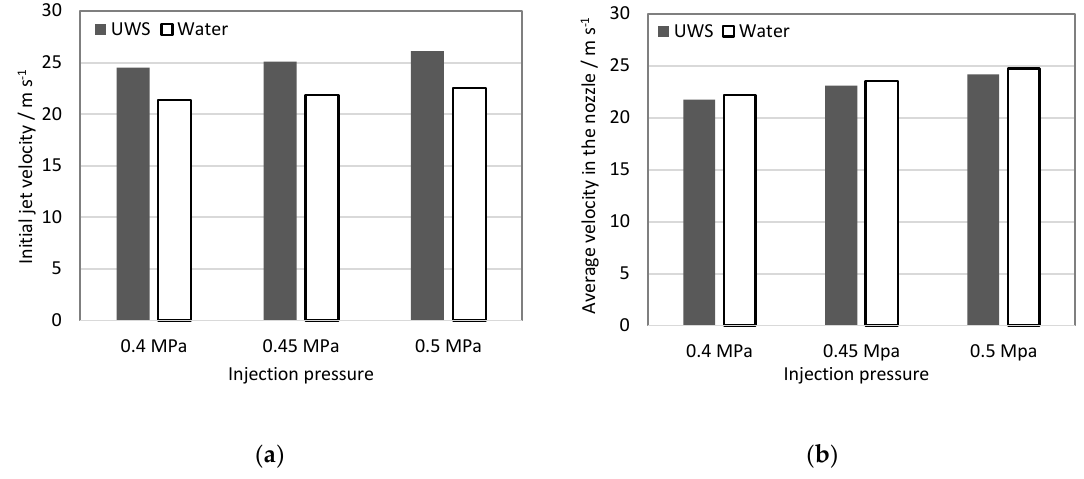
Figure 4. ( a ) initial jet velocity; ( b ) static flow velocity (from Table